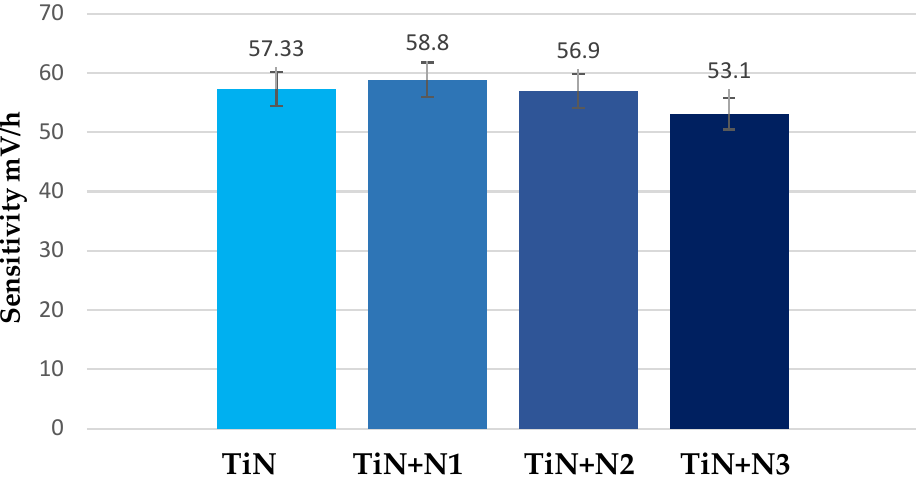
Figure 5. Thickness optimization of Nafion on 85 nm TiN film by assessing the sensitivity as a key performance indicator.